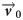
Cosine similarity index between v→0 and u→0.A) Similarity index for all cells. A1) Example cell with a high similarity index (0.88). v→0 (black) was approximately equal to u→0=0.97v→1−0.19v→2−0.14v→3 (gray). A2) Example cell with the lowest similarity index (0.70). v→0 (black) was approximately equal to u→0=0.71v→1 (gray). B) Comparison of four models. The coefficient of determination (R2) produced by the general quadratic model (GQM) was compared to the non-linear input model (NIM), a two-dimensional spike-triggered covariance analysis (STC2), and a linear model (STC1). Black squares denote the mean R2 and the lines represent 1 standard deviation. GQM performed significantly better than STC2 and STC1 (p < 0.03 in both cases).